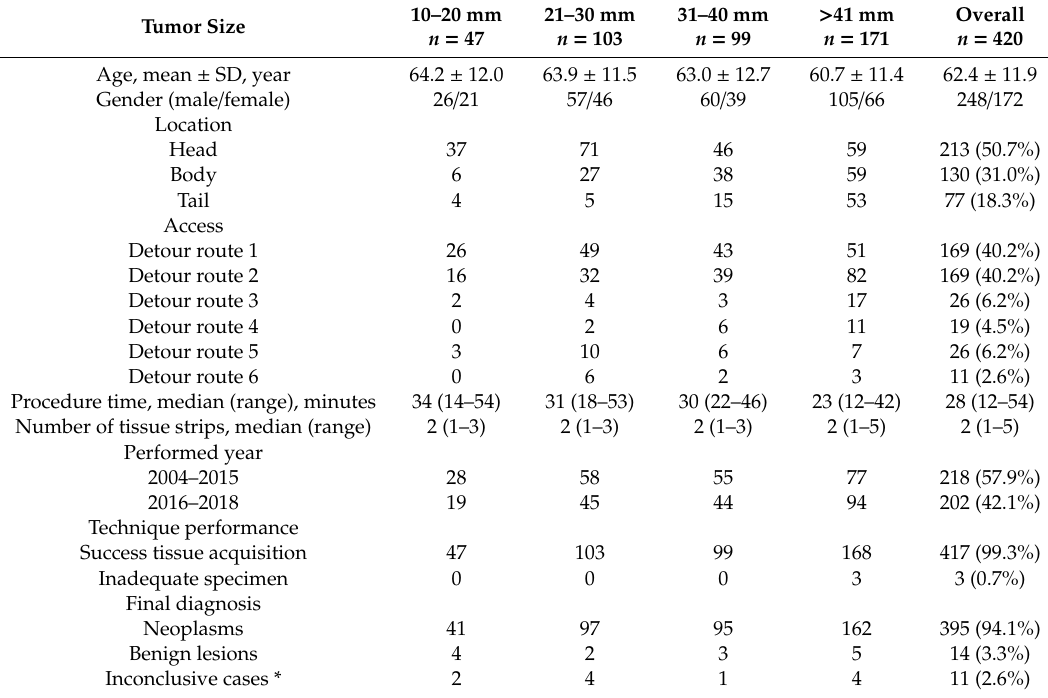
Table 1. Patient demographics and clinical characteristics.